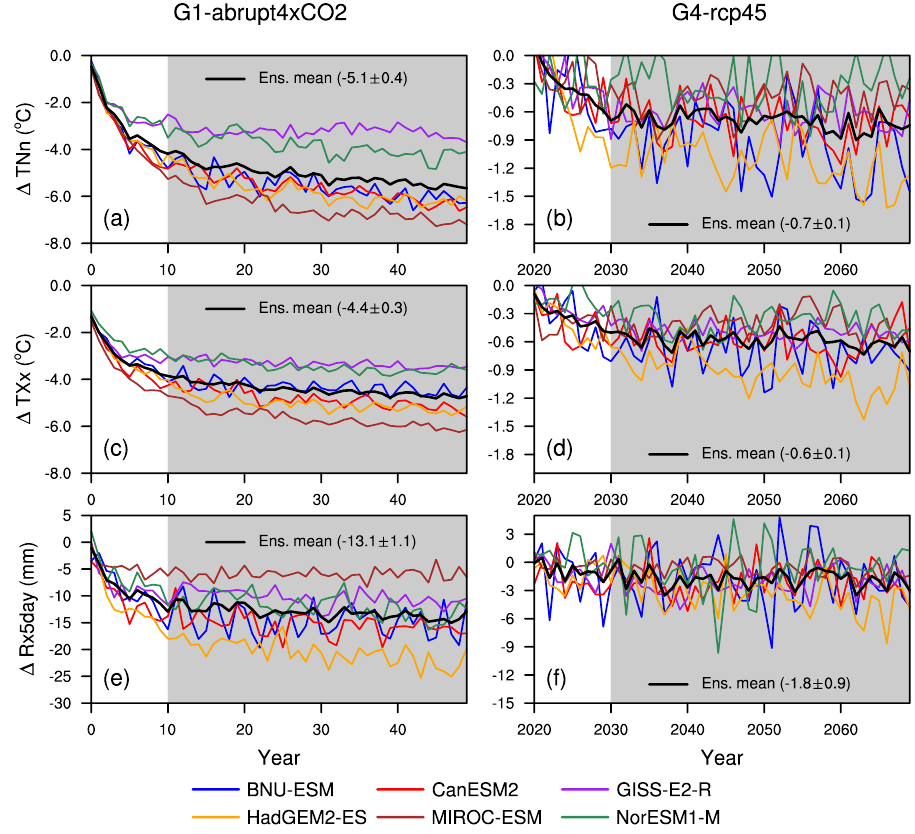
Figure 3. Time series of the difference in global mean extreme indices (as labelled on the ordinate of panels (a) , (c) and (e) ) between G1 − abrupt4 × CO2 (a, c, e) and G4 − rcp45 (b, d, f) for all models analysed. The black curves are the multi-model means, and grey shading indicates the 40-year analysis period for each experiment used in this study, with the ensemble mean value also shown in each